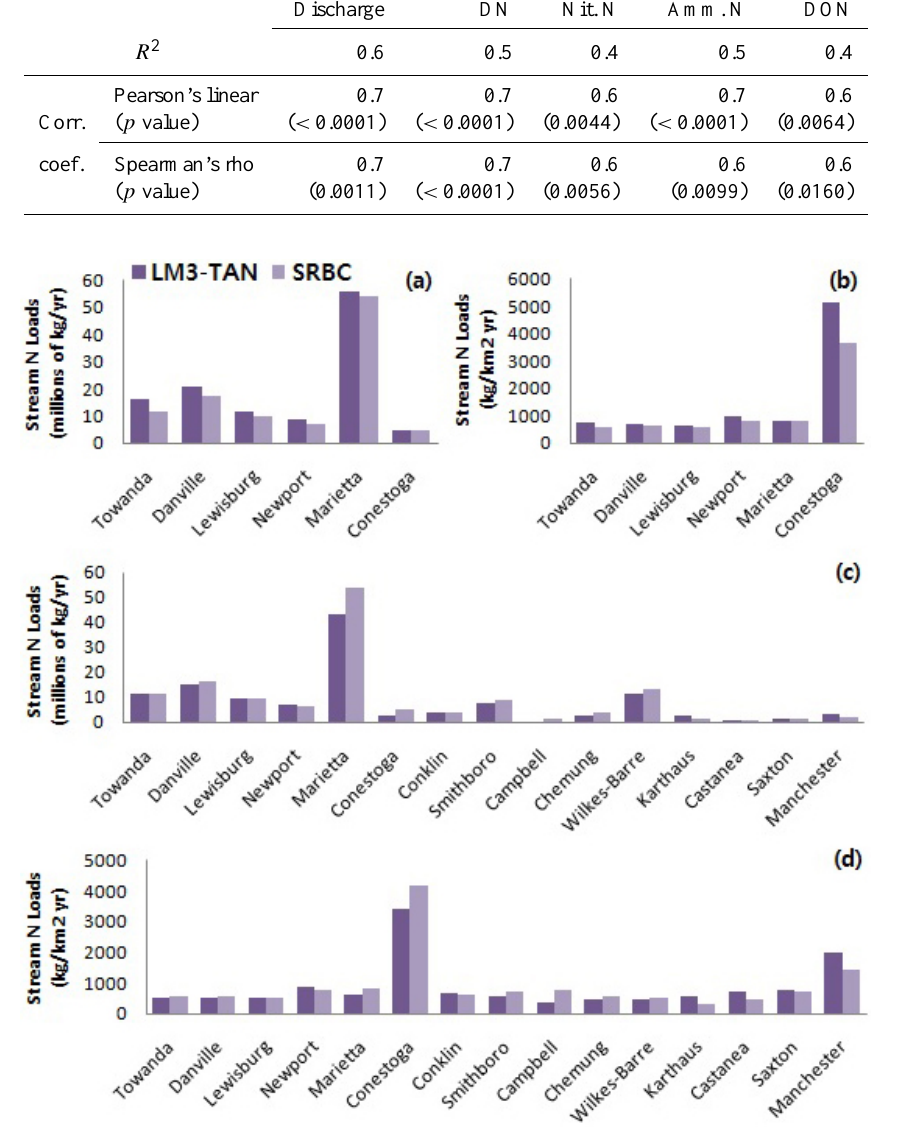
Figure 6. Seventeen-year (1989–2005) average simulated and reported (SRBC) stream N loads at the six long-term monitoring sites in (a) millions of kgyear − 1 and (b) kgkm − 2 year − 1 ; simulated and reported stream N loads for the year 2005 at the 15 monitoring sites in (c) millions of kgyear − 1 and (d) kgkm − 2 year − 1